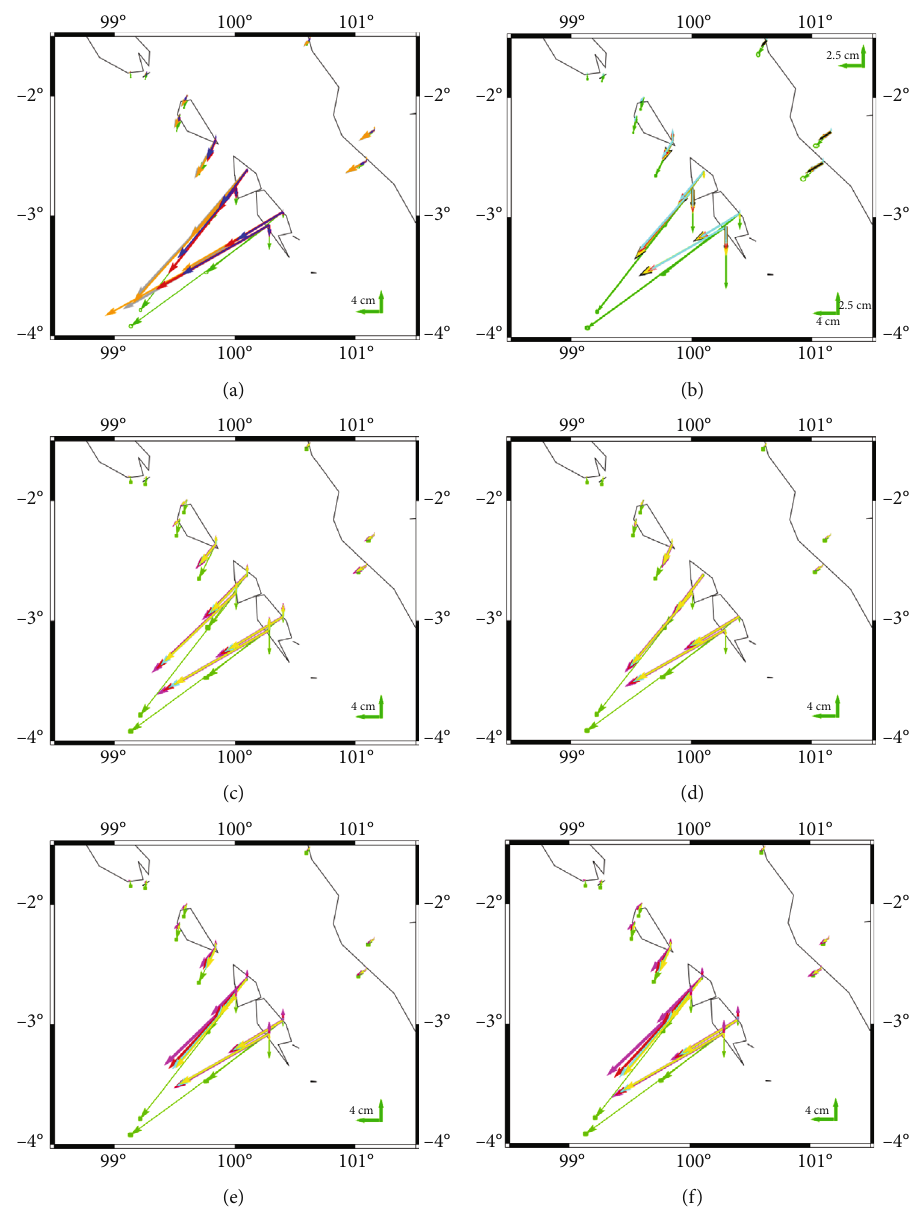
Figure 6: The predicted coseismic deformation at the GPS stations. The green arrow indicates the GPS observation data. The arrow scale at the bottom right corner of the fi gure shows 4cm of the horizontal o ff set and the vertical o ff set used for the GPS o ff set except (b). (a) The surface deformation from the HOM-0topography model (orange arrow), HOM-topography model (gray arrow), HET-0topography (red arrow), and HET-topography (blue arrow). (b) The surface deformation from the wedge variation model. Length 175km – width 16km (cyan arrow), length 200km – width 16km (gray arrow), length 200km – width 21km (yellow arrow), length 200km – width 26km (black arrow), and length 225km – width 16km (red arrow). The scale arrow at the bottom right corner shows 4cm for the horizontal o ff set and 2.5cm for the vertical o ff set used for the GPS o ff set on the islands. Another arrow scale at the top right corner shows 2.5cm for both horizontal and vertical displacement used for the GPS o ff set on mainland. (c – f) The surface deformation from the rigidity variation. (c) The model with constant Vp/Vs 1.6 and Vp variation 5.1-5.7km/s. Vp 5.1km/s (yellow arrow), Vp 5.3km/s (cyan arrow), Vp 5.5km/s (red arrow), and Vp 5.7km/s (magenta arrow). (d) The model with constant Vp/Vs 2.2 and Vp variation 5.1-5.7km/s. Vp 5.1km/s (yellow arrow), Vp 5.3km/s (cyan arrow), Vp 5.5km/s (red arrow), and Vp 5.7km/s (magenta arrow). (e) The model with constant Vp 5.1km/s and Vp/Vs variation 1.6-2.2. Vp/Vs 1.6 (magenta arrow), Vp/Vs 1.8 (red arrow), Vp/Vs 2.0 (cyan arrow), and Vp/Vs 2.2 (yellow arrow). (f) The model with constant